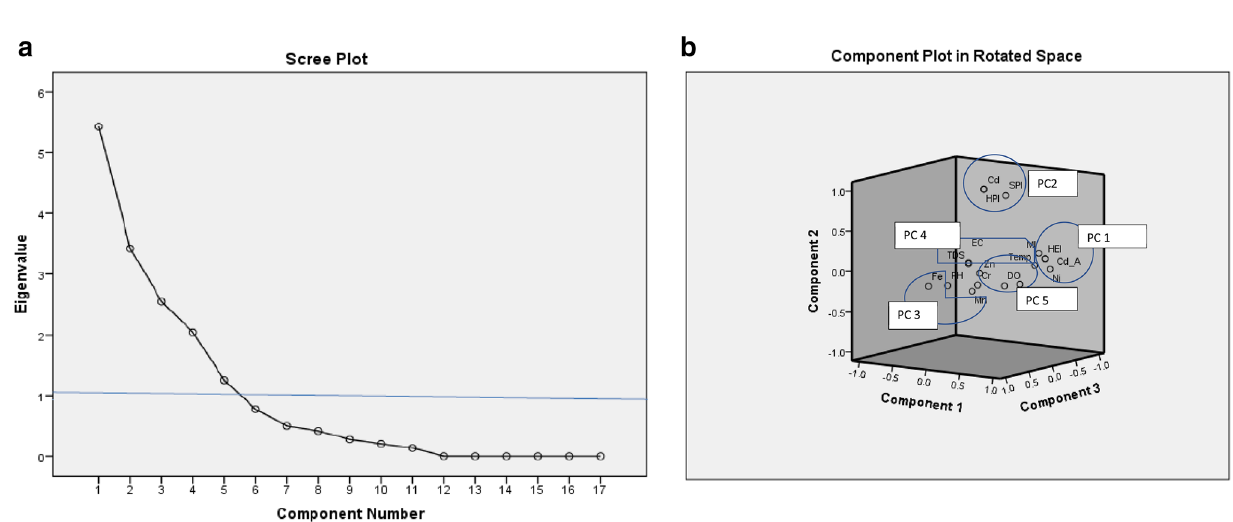
Fig. 6 a Scree plot of the different components. b The plot of rotated components in